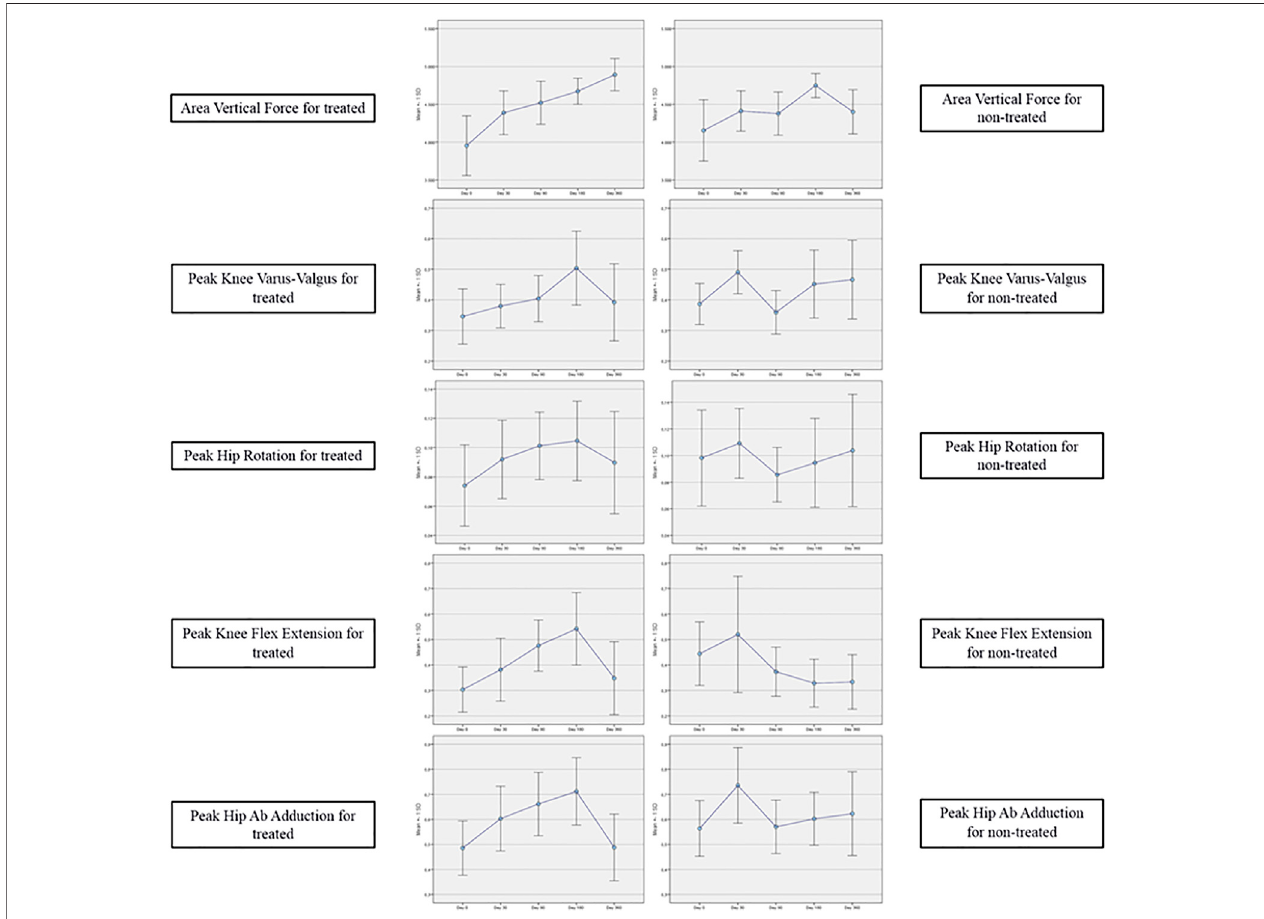
FIGURE 4 | GAIT parameters grouped by treatment (cohort without outliers).